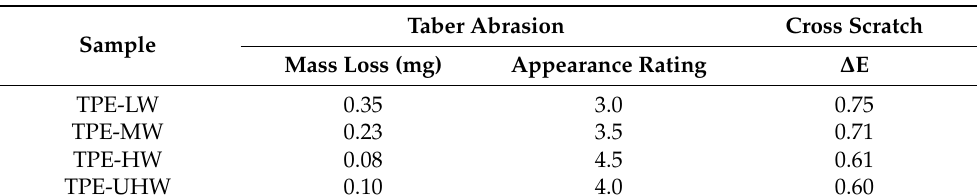
Table 2. Mechanical properties of TPE prepared by SEBS with similar structure and various molecular weights.